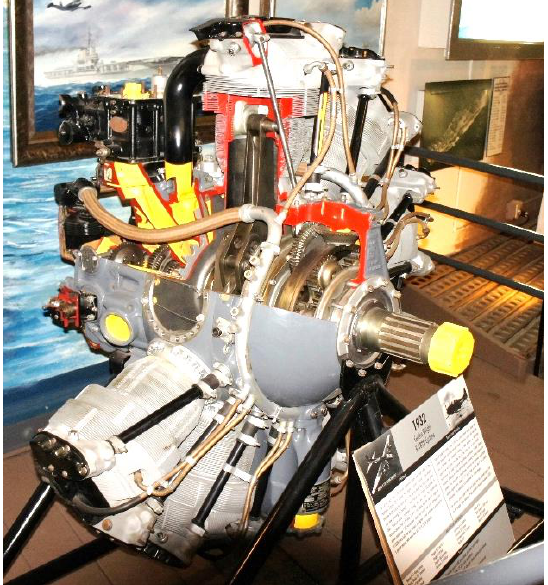
Fig. 8. Cross-section of the Cyclone Wright R-1820 engine (San Diego Air and Space Museum, photo by the